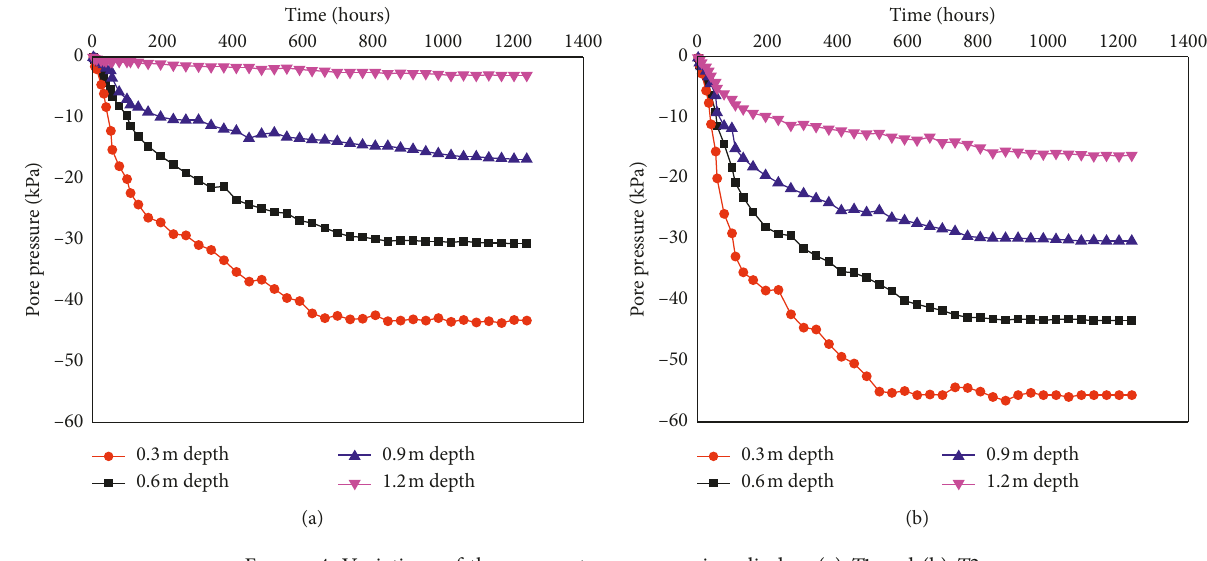
Figure 4: Variations of the pore water pressures in cylinders (a) T 1 and (b) T 2.